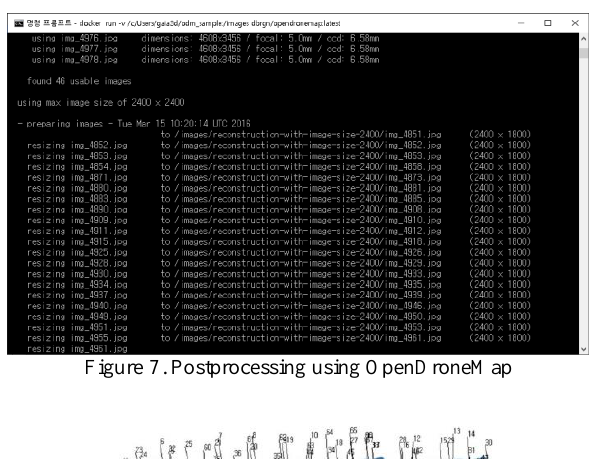
Figure 7. Postprocessing using OpenDroneMap